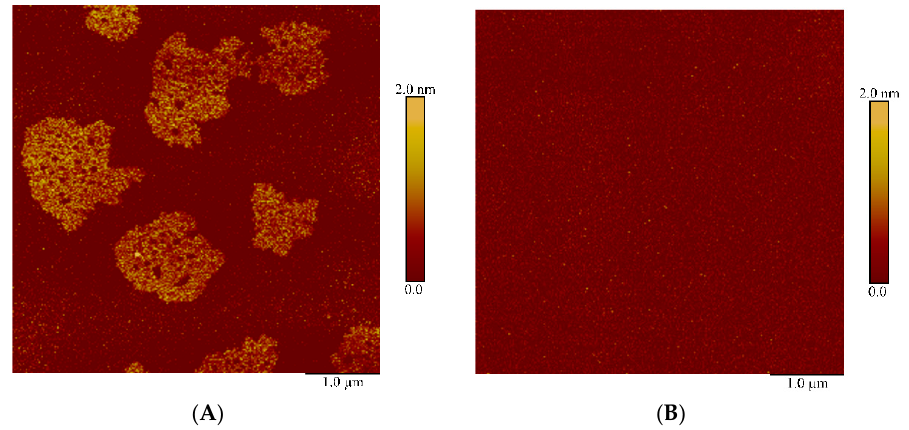
Figure 4. Typical AFM images obtained after incubation of SuccBB -activated ( A ) and non-activated ( B ) APTES-modified mica in 10 − 9 M HRP solution upon UV irradiation.